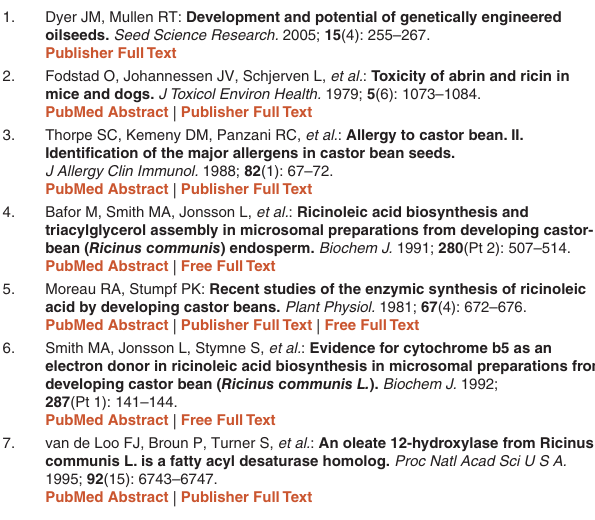
Table S2. Fatty acid profile from RcCb5 CL37 T